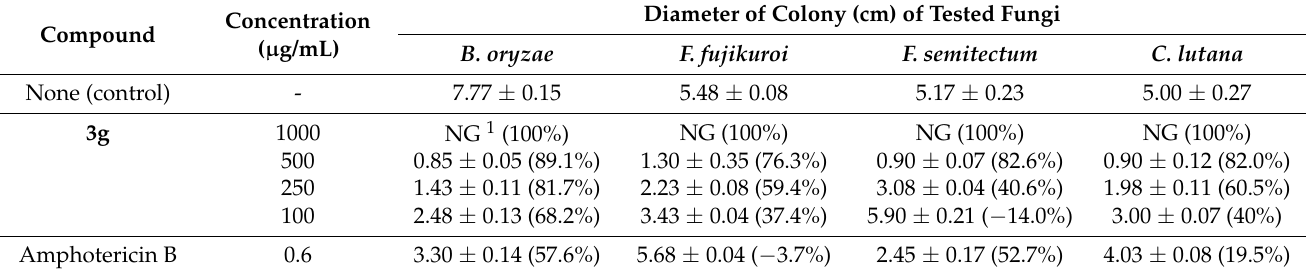
Table 2. Inhibition activity of 2-octyl-2,3,4,9-tetrahydro-1 H -pyrido[3,4- b ]indole ( 3g ) against a diameter of a colony of phytopathogenic fungi.